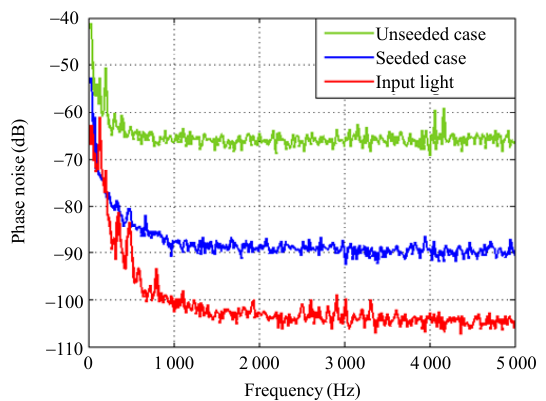
Fig. 16 Output phase noise without and with seed and the phase noise of the input light ( P =800